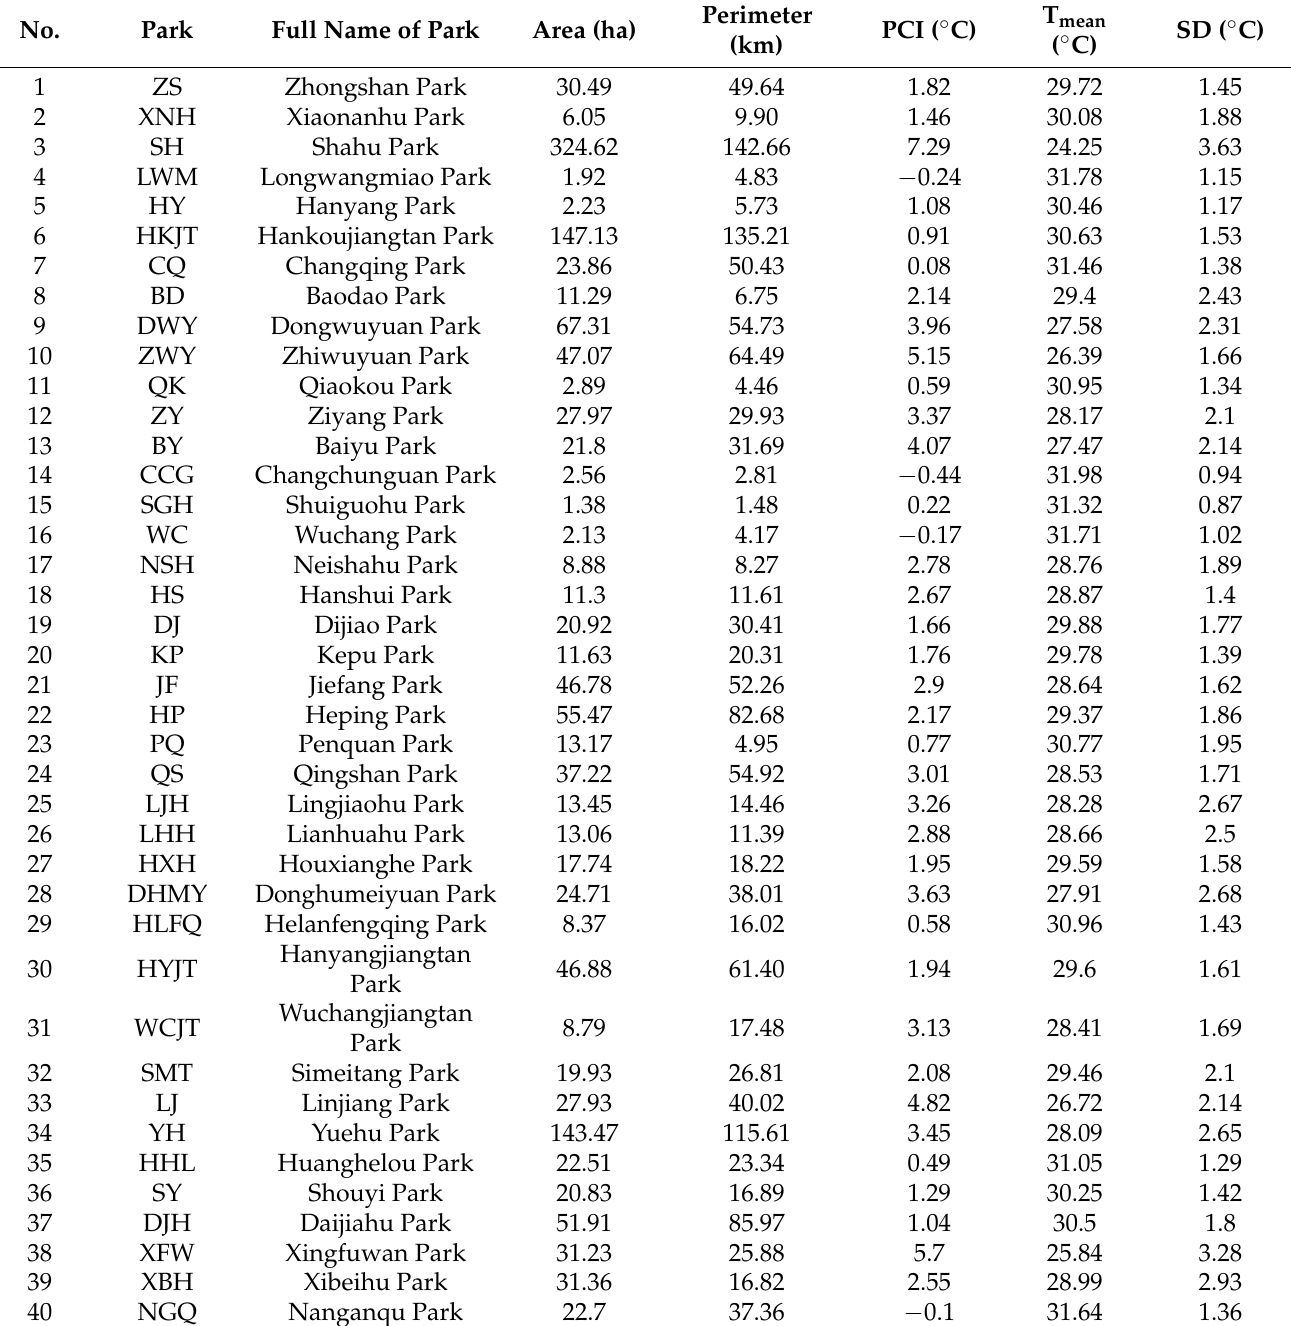
Table 2. Basic information and park cool island (PCI) intensity for different sample